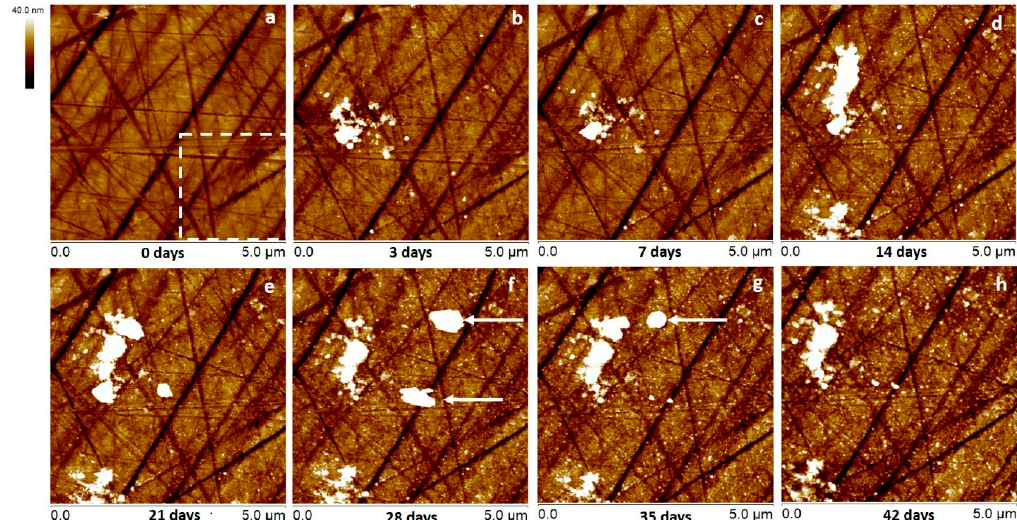
Figure 5. Atomic force microscopy (AFM) images of a chalcopyrite (112) surface leached at pH 1 and in the presence of ferric: 0 ( a ), 3 ( b ), 7 ( c ), 14 ( d ), 21 ( e ), 28 ( f ), 35 ( g ) and 42 ( h ) days.